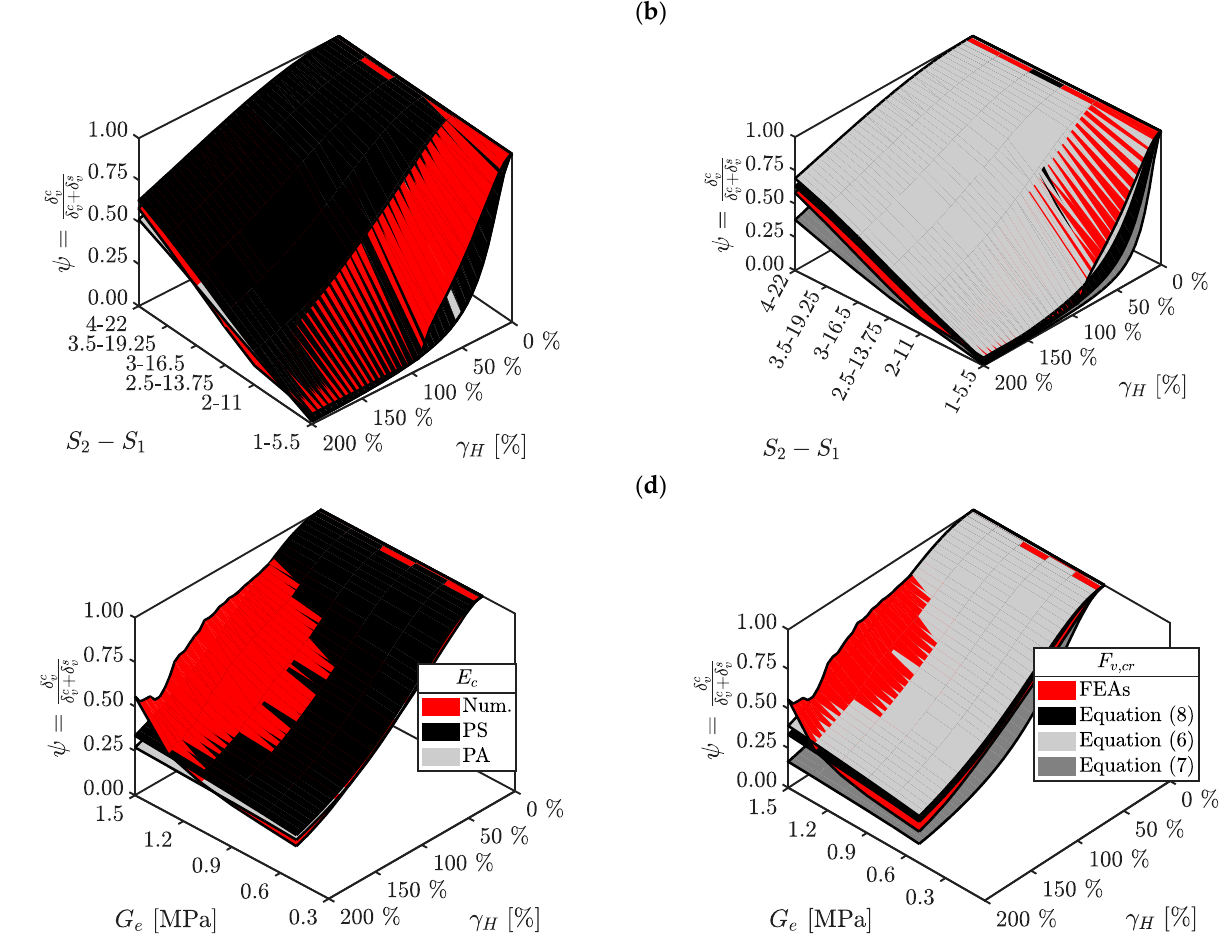
Figure 6. Analytical numerical comparison on the trends of the ψ function with the shear strain and: ( a , b ) primary and secondary shape factors; ( c , d ) shear modulus of the rubber.